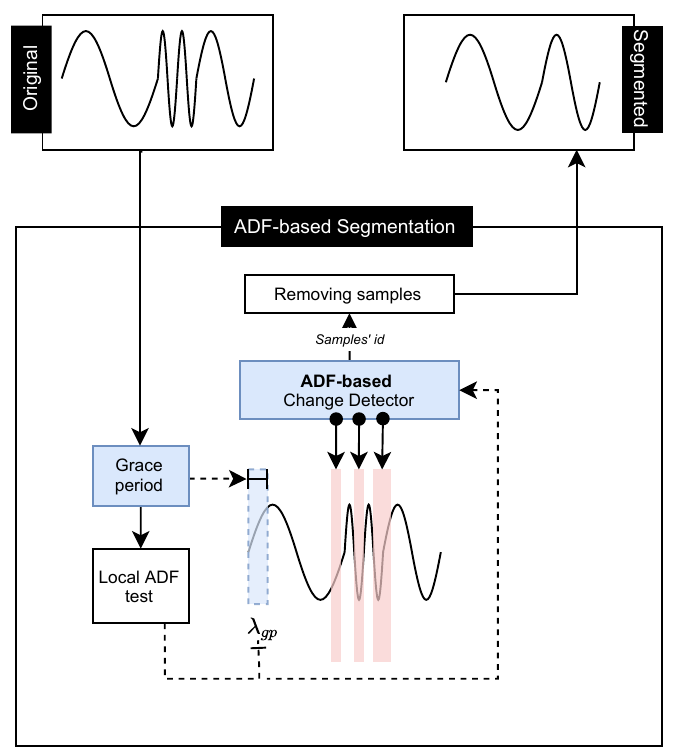
Figure 2. Methodology proposal of ADF-based